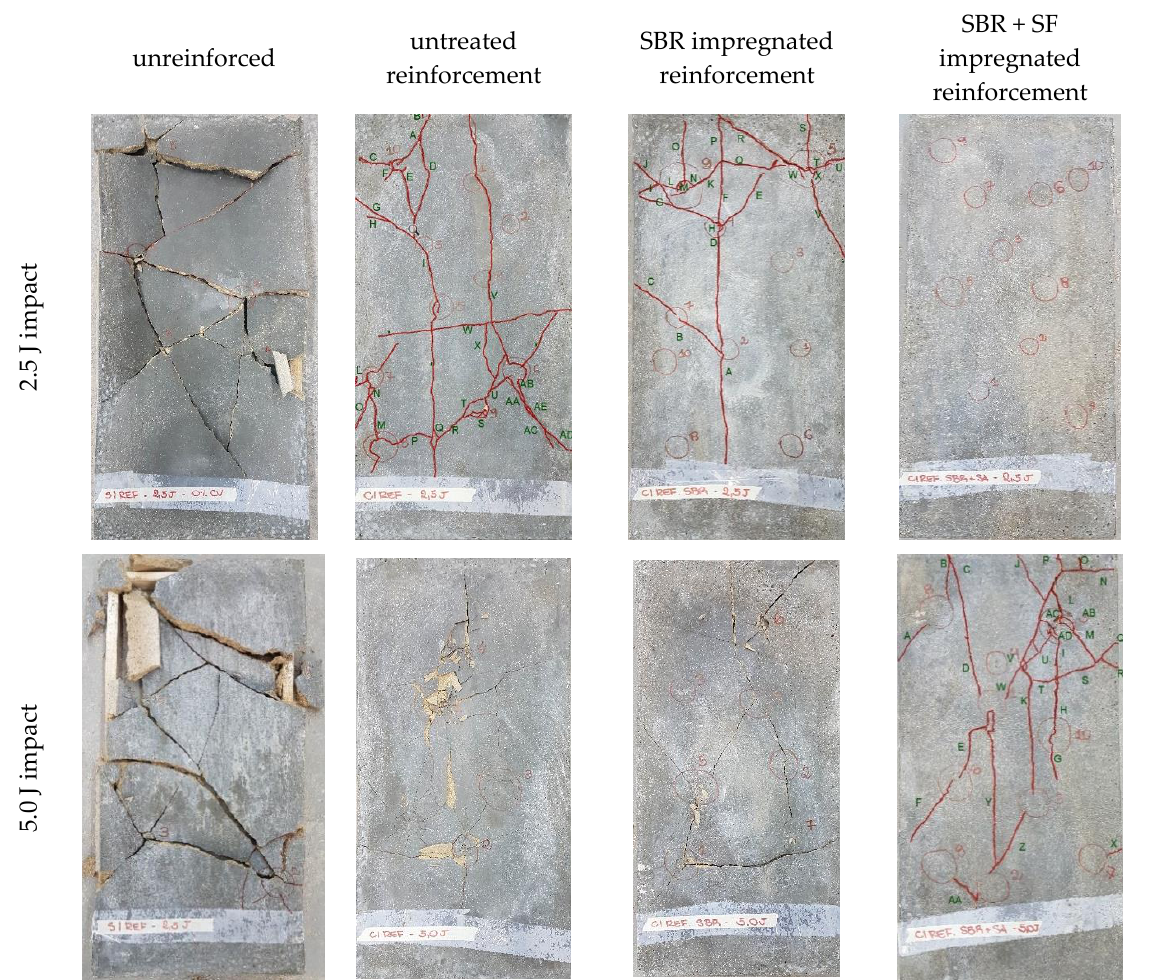
Figure 12. Visual surface appearance of test bodies for all composites subjected to impact testing. Table 4. Average depth, divot diameters, and fissured area from impact testing on all